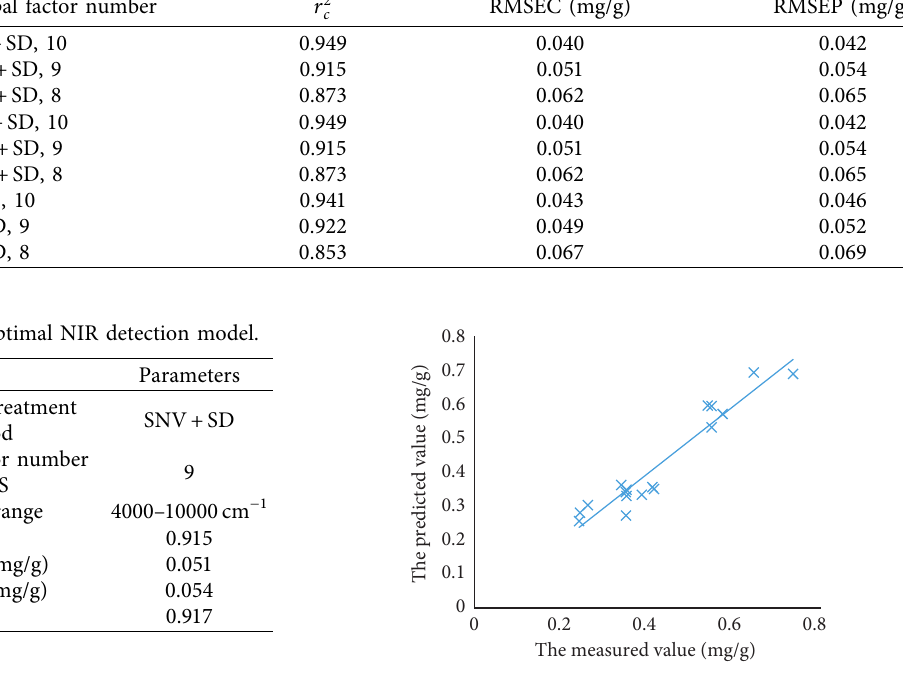
Figure 4: Comparison between predicted values and experimental